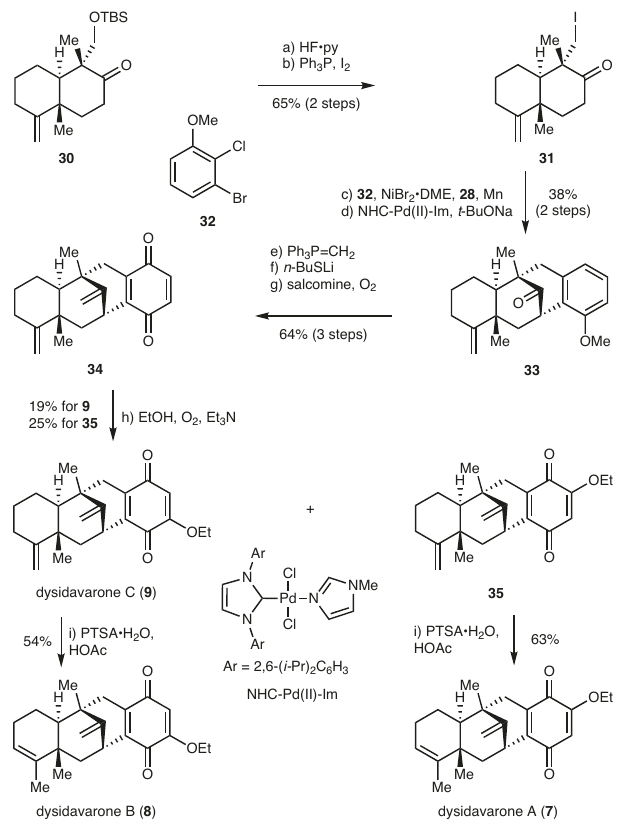
Fig. 4 | Syntheses ofdysidavarones A – C. Reagents and conditions: a HF·Py:THF = 1:4,40°C, 2h, 73%; b I 2 (2.0equiv),PPh 3 (3.0 equiv),benzene, 23°C,16h, 89%; c 32 (3.0equiv), 28 (0.2equiv),NiBr 2 (cid:129) DME(0.2equiv),Mn(3.0equiv),DMAc,23°C,16h; d NHC-Pd(II)-Im (0.2 equiv), t -BuONa (3.0 equiv), 1,4-dioxane, 110°C, 3h, 38% (2 steps); e CH 3 PPh 3 Br (10.0 equiv), t -BuOK (10.0 equiv), toluene, 120°C, 7h, 88%; f n -BuSH (10.0 equiv), n -BuLi (10.0 equiv),HMPA, 110°C, 4h, 85%; g salcomine (3.0 equiv), O 2 , acetonitrile, 23°C, 85%; h Et 3 N (50.0 equiv), O 2 , EtOH, 30°C, 9 , 19%, 35 , 25%; i